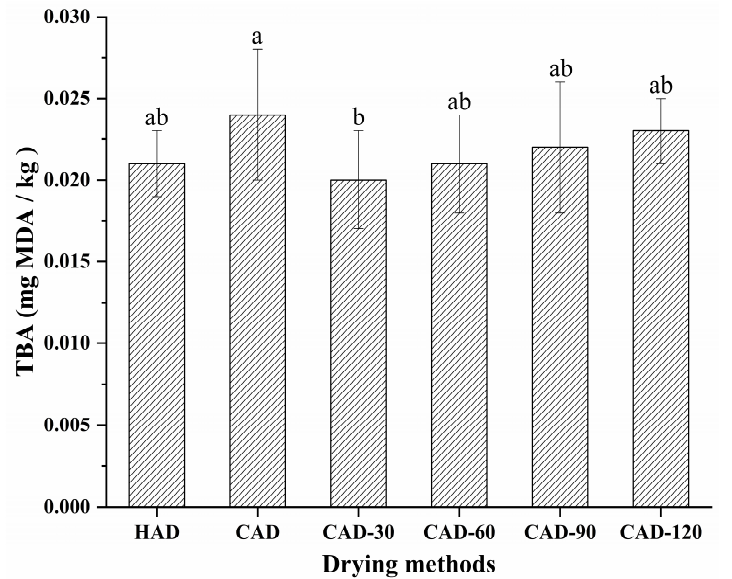
Figure 3. Changes in thiobarbituric acid (TBA) values in semi-dried pufferfish fillets. Values with different superscripts are significantly different ( p < 0.05). HAD, hot air drying; CAD, cold air drying; CAD-30, cold air drying for 30 min; CAD-60, cold air drying for 60 min; CAD-90, cold air drying for 90 min; CAD-120, cold air drying for 120 min.